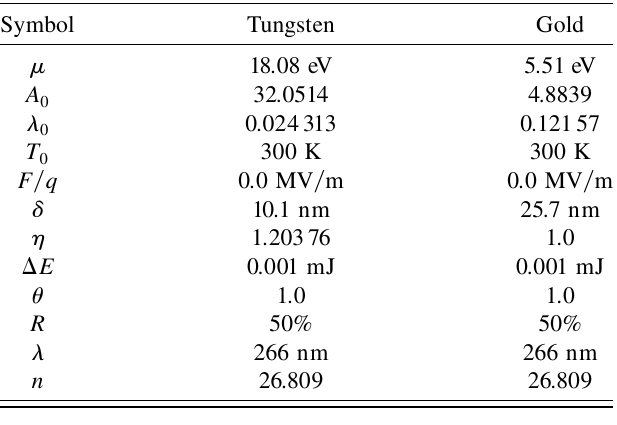
Material parameters.